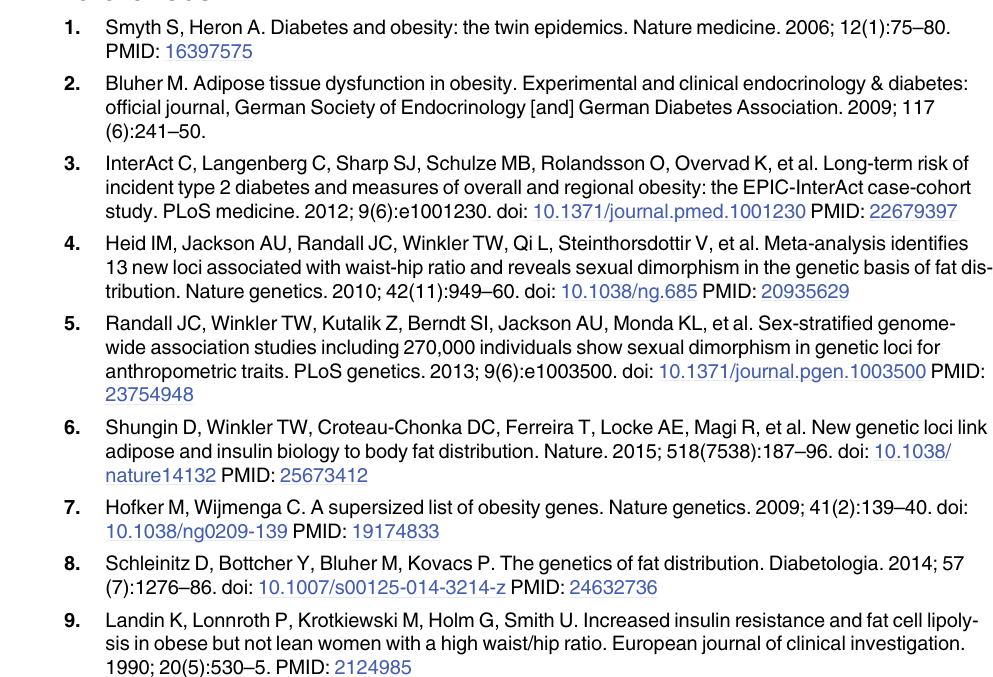
S1 Table. Genotypes of SNPs failing the Hardy-Weinberg equilibrium test. S2 Table. Linear regression analysis of the effect of the smaller WHRadjBMI-increasing SNPscore on lipolysis phenotypes. S3 Table. Genotype data. S1 Fig. Schematic demonstrating the different steps by which isoprenaline and dibutyryl cyclic AMP (dcAMP) stimulate activation of lipolysis to produce release of glycerol. In blue, endogenous cellular components, in red the 2 stimuli used in this study. Isoprenaline-stimu- lated activation relies upon the efficient function of the β -adrenergic receptor signalling to acti- vation of protein kinase A. In contrast, dcAMP directly activates Protein kinase A to initiate glycerol